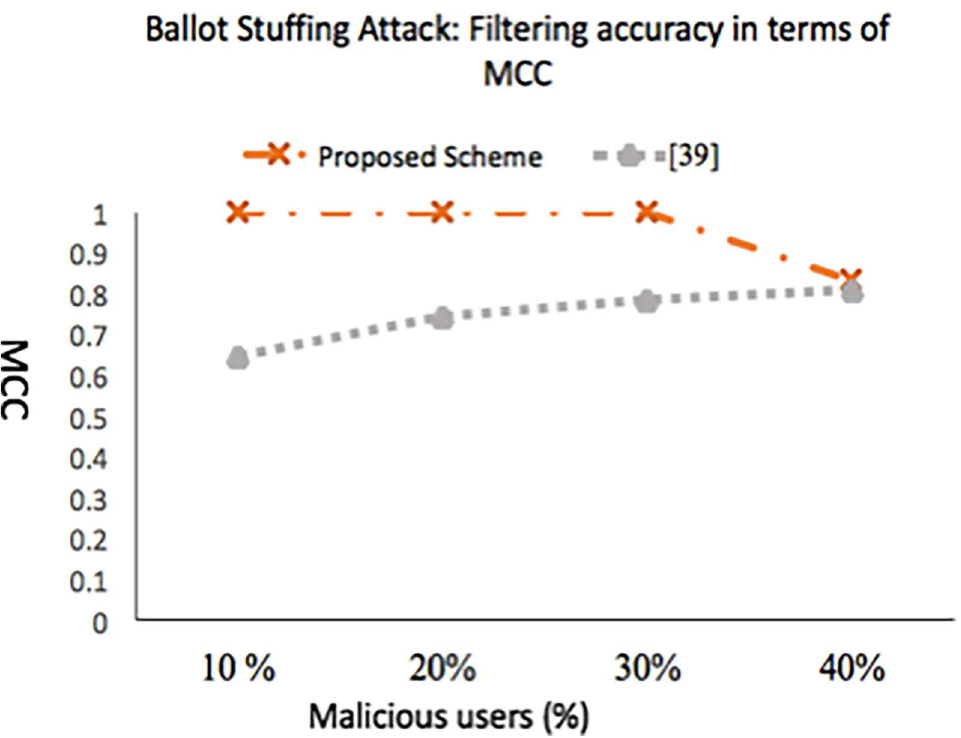
Fig 11. Filtering accuracy in terms of MCC (ballot-stuffing attack done in t r